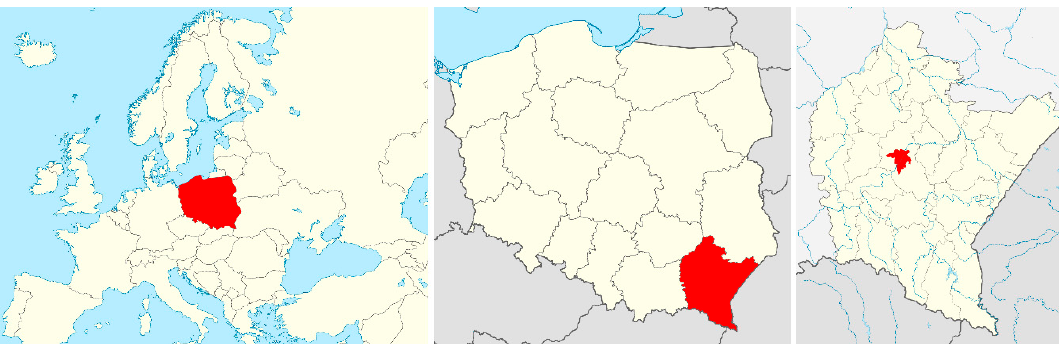
Figure 2. Location of Rzeszów. Source: own study.